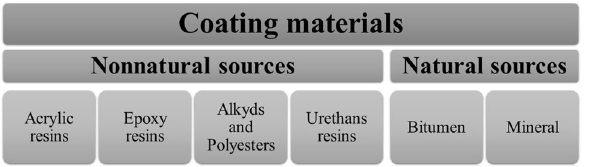
Figure 1. Most common coatings materials used for protecting concrete structures 9–12 .